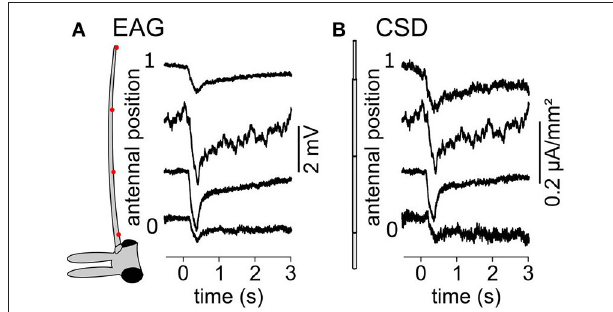
FIGURE 9 | CSD maps of a C. sacchariphagus antenna in response to Z3-hexen-1-ol stimulation. (A) EAG response was recorded at four antennal positions of the antenna of a female C. sacchariphagus . The drawing on the left of the head and one antenna of C. sacchariphagus indicates the positions of recording (red dots). (B) A four compartments antennal model (left) was used to estimate the CSD response at the four positions (right).